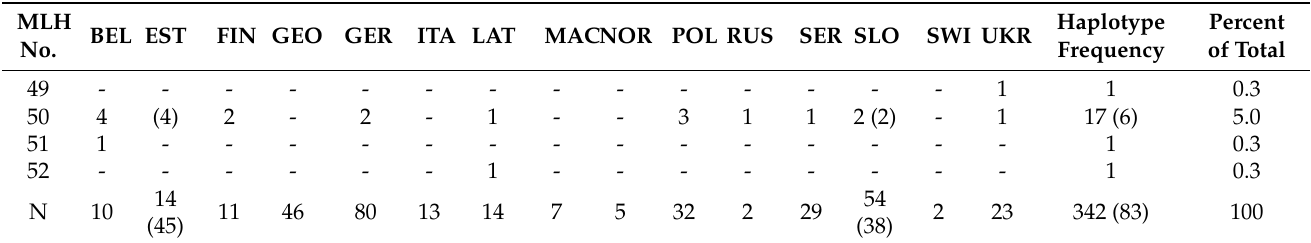
Haplotypes of first arrivals of D. sapinea into Estonia are highlighted in bold and underlined. If several isolates were obtained from single tree or small group of trees then only one randomly chosen haplotype was used and several isolates from same tree were used in small spatial scale analyses and were indicated in brackets. Percentage calculation included haplotypes, which were used in the main study. Subpopulation codes: Belarus—BEL, Estonia—EST, Finland—FIN, Georgia—GEO, Germany—GER, Italy—ITA, Latvia—LAT, North